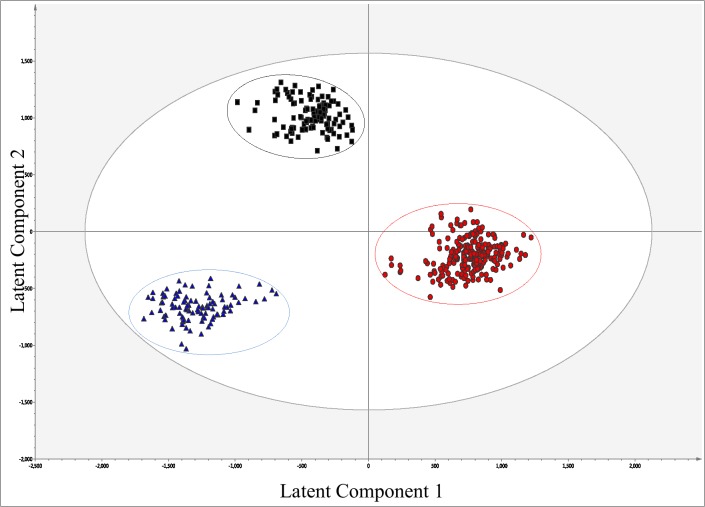
Multivariate model generated from HRMS analysis of human plasma.The OPLS-DA scores plot shows Controls (red circles), MCI (black squares) and MCI_AD (blue triangles). R2 = 95.6% and Q2 = 91.6%. R2 (cumm) indicates the variation described by all components in the model and Q2 is a measure of how accurately the model can predict class membership. Essentially it validates the statistical model by leaving 1/7th of the data out of the model and then predicting their class membership [24].